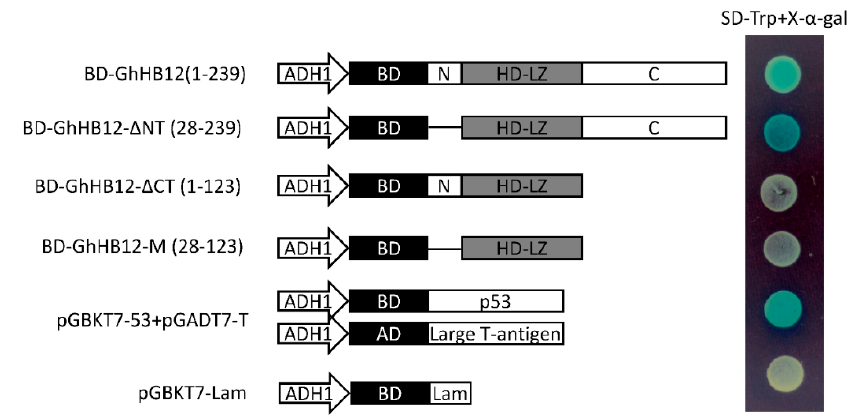
Figure 2. Histochemical localization of β -glucuronidase (GUS) activity in pGhHB12:GUS cotton plants. ( A ) GhHB12 promoter drives GUS expression in the cotyledons and primary roots of the 3-day-old seedlings. ( B ) GhHB12 promoter preferentially drives GUS expression in cotton primary roots, tips of lateral roots, vascular tissues, and floral organ. GUS staining in the ( 1 ) primary roots and ( 4 ) root hairs of the 3-day-old seedlings, ( 2,3 ) lateral roots of the 10-day-old seedlings, ( 5 ) section of stem, ( 6 ) petiole, ( 7 ) shoot apices and young leaves of 30-day-old plants, a longitudinal section of ( 8 ) buds and ( 9 ) flowers. ( C ) Wounding stress regulation of GhHB12 promoters. GUS activity was detected in the mechanically damaged hypocotyls and cotyledons of the 10-day-old seedlings.